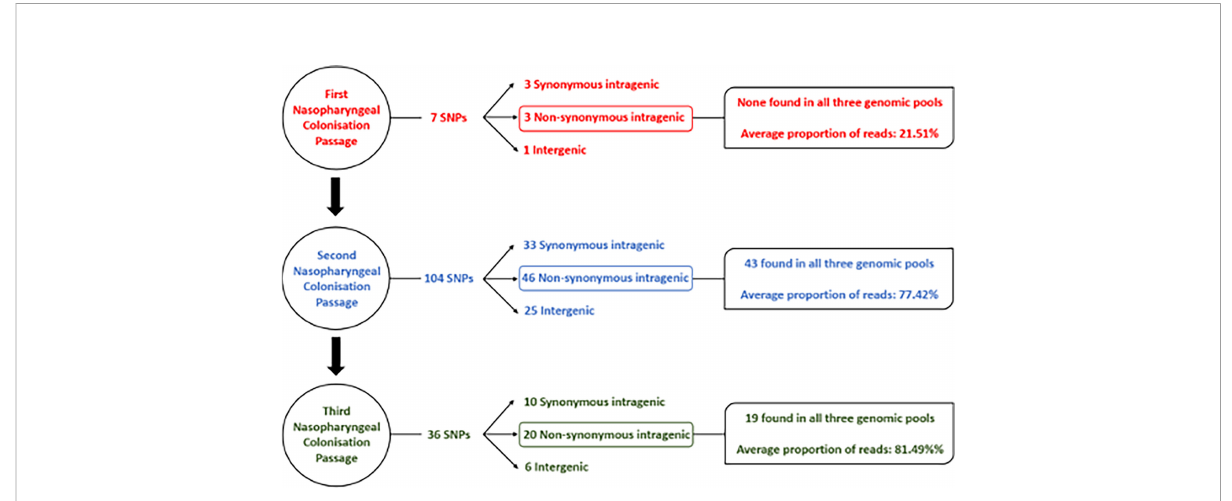
FIGURE 3 Flow chart detailing sequence variants identi fi ed in S. aureus isolates after each nasopharyngeal passage.